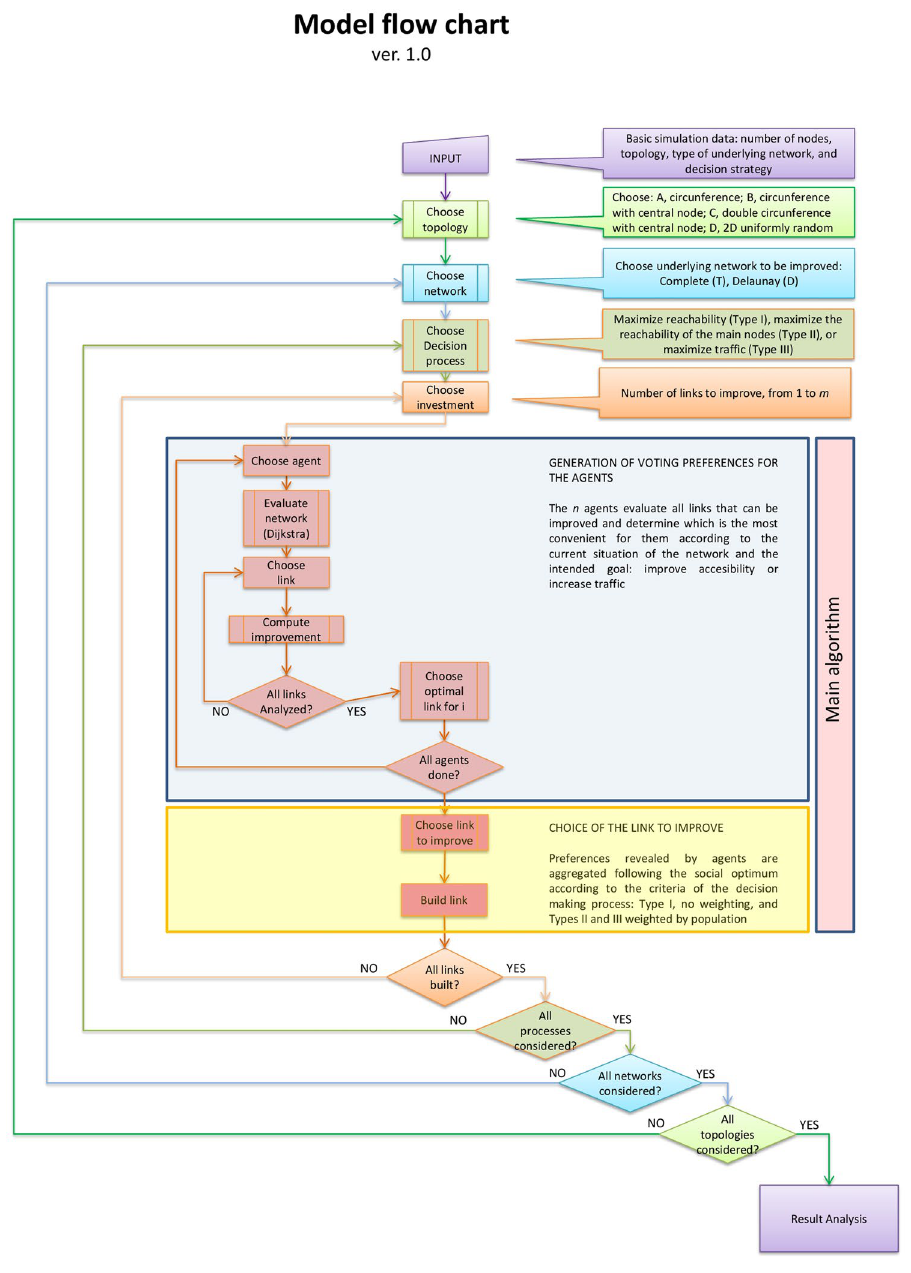
Figure 1. Flow chart of our model, showing the integration of the differerent